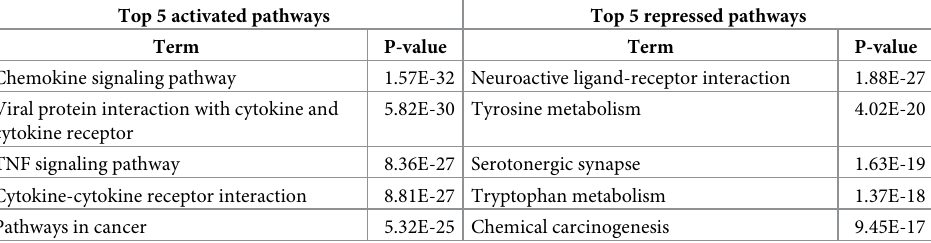
Table 4. Top 5 activated and top 5 repressed pathways based on p-value in RHD compared to ARF obtained using